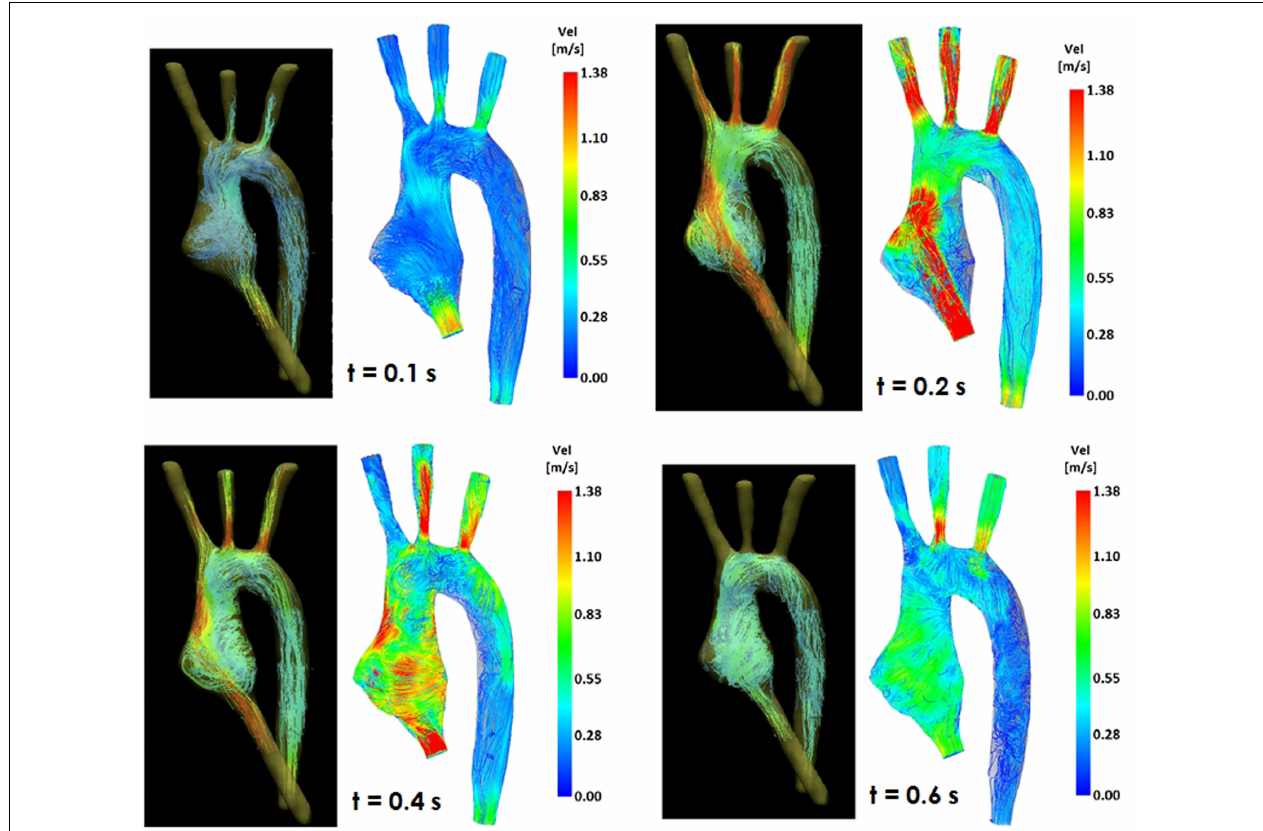
FIGURE 4 | Comparison of flow streamlines in the TGA 3D model, 4D CMR data ( left ) and CFD results ( right ), at four different time points in the cardiac cycle